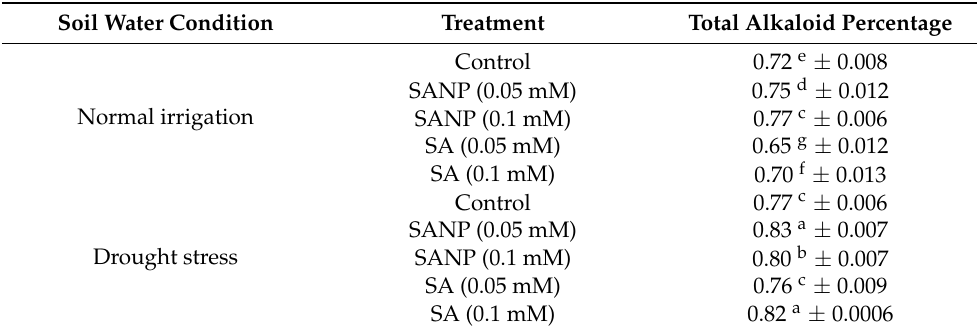
Table 5. Effect of drought stress, bulk SA, and SANP on total alkaloid